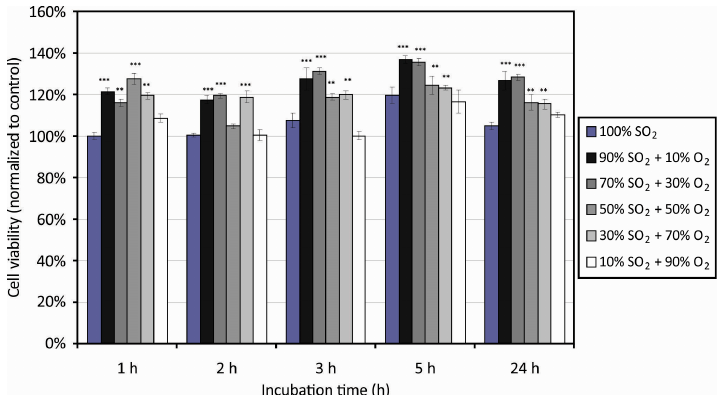
Figure 9. Results of the MTT assay for HUVEC cell proliferation on PET surfaces treated in various SO 2 + O 2 mixtures. Symbols * represent statistical significance ( ** represents statistical significance at p < 0.01 compared with the control. *** represents statistical significance at p < 0.001 compared with the control). Mean values (± SE) for the respective triplicates are given.